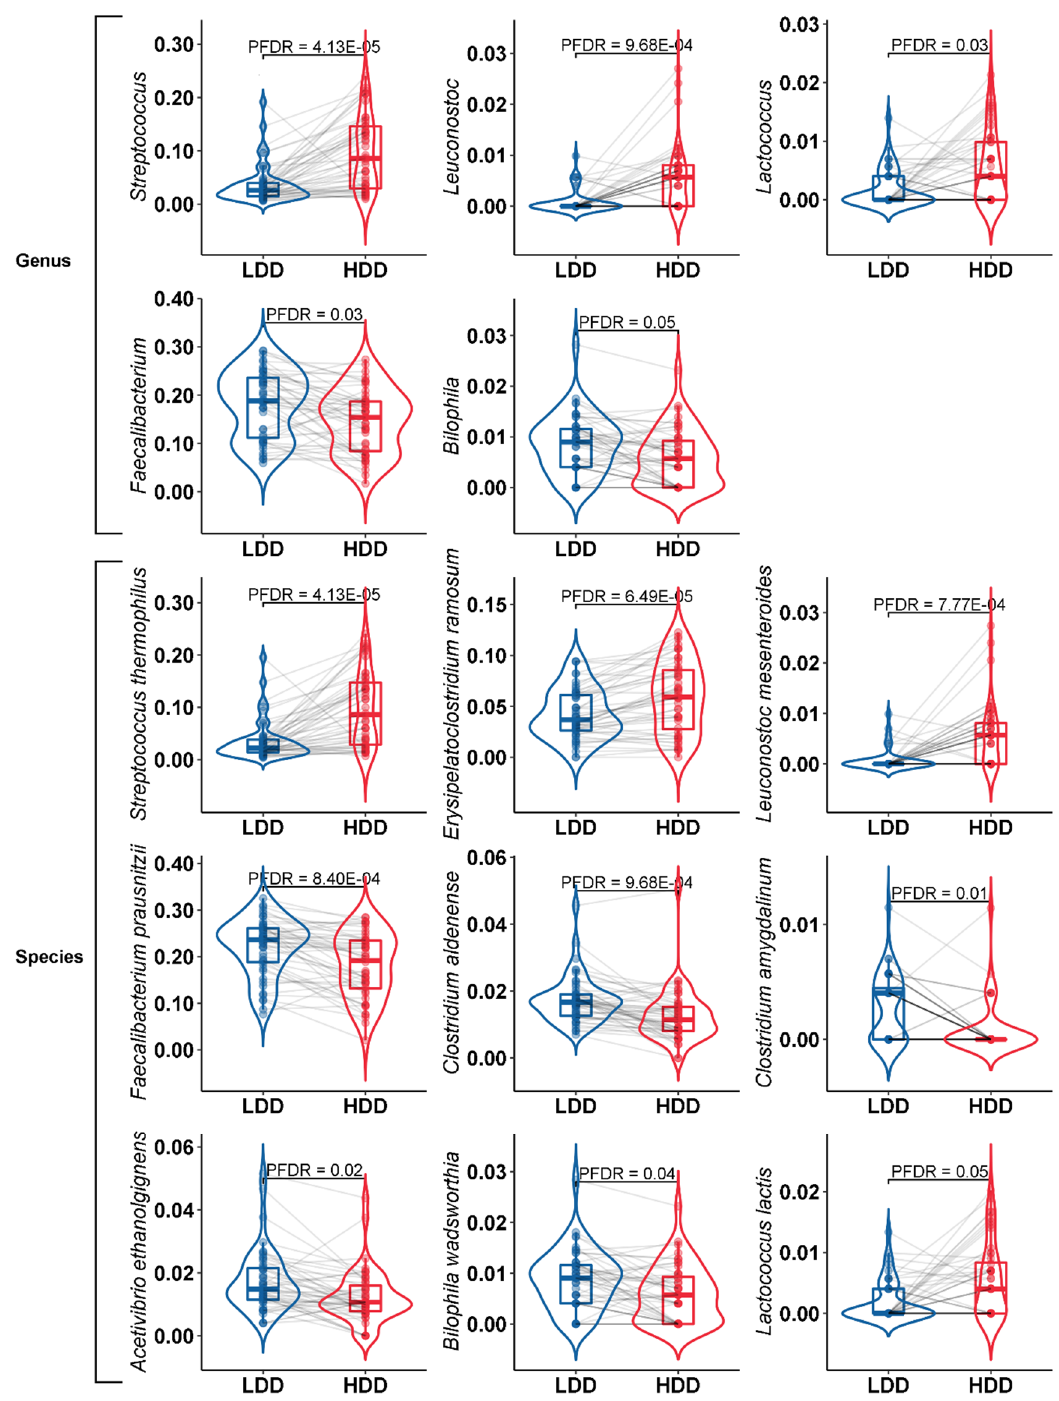
Figure 3. Violin plots of the relative abundance (arcsine square root transformed) of the different bacterial genera and species after the LDD and the HDD. Violin plots in blue represent the LDD and violin plots in red represent the HDD. Taxonomic level is indicated by Genus or Species.